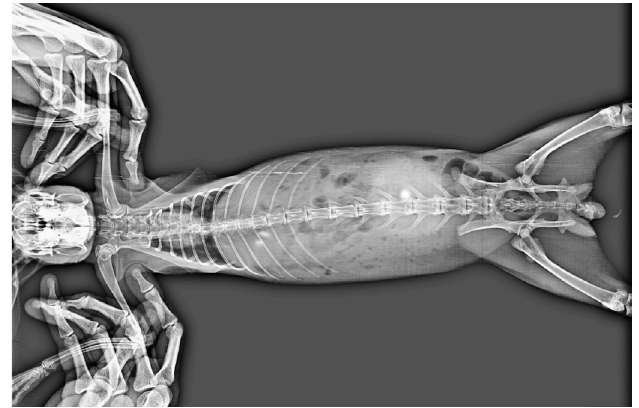
FIGURE 7 - X-ray image of formulation containing MMZ with barium sulphate after eight hour.